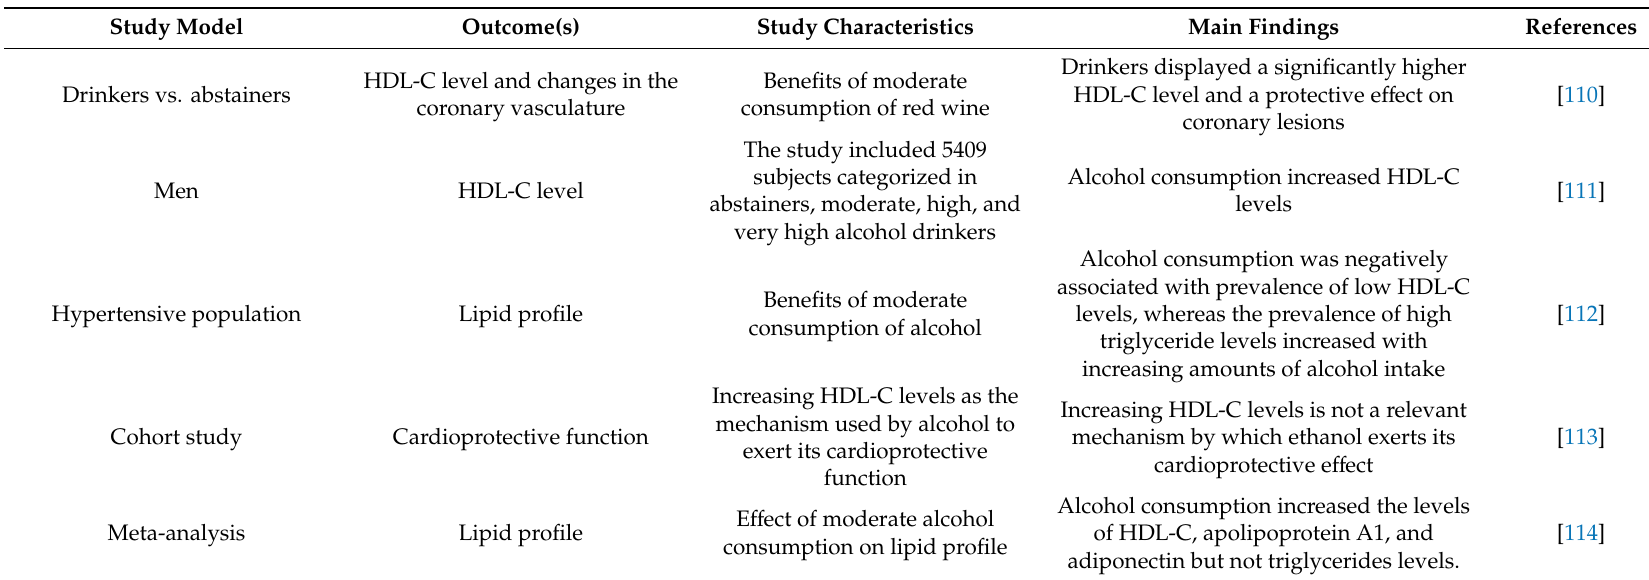
Table 2. Summary of studies assessing the relationship between moderate alcohol consumption and lipid profile. HDL-C: high-density